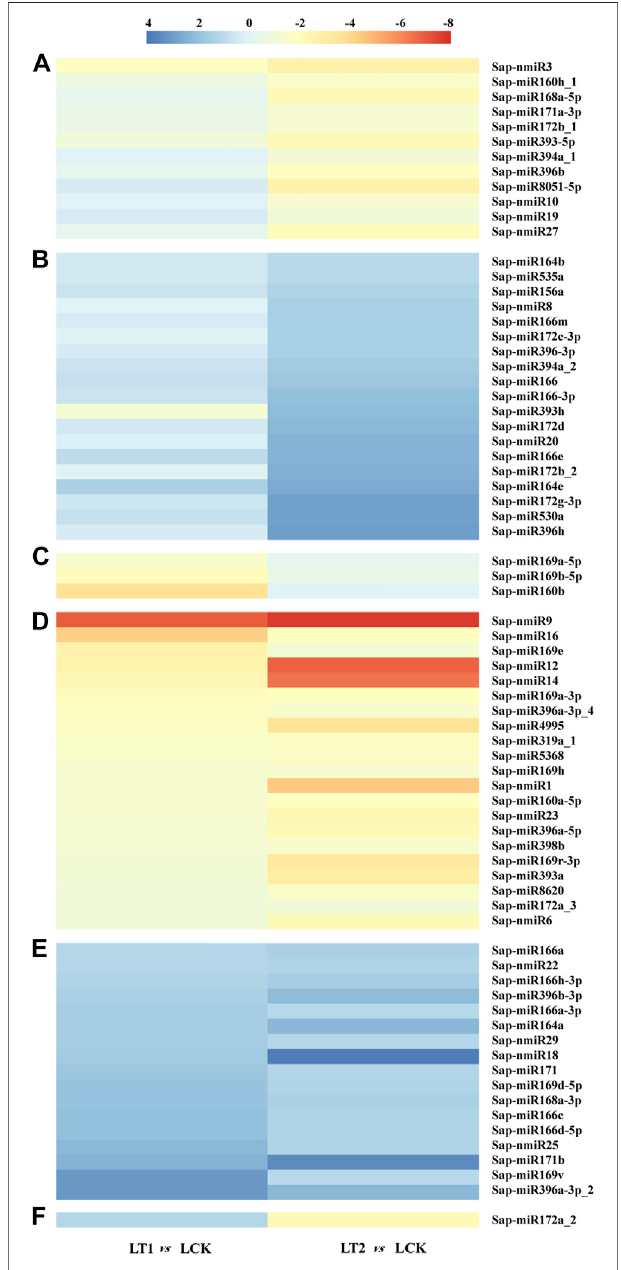
FIGURE 5 | Differentially accumulated S. apetala miRNAs after 0 days (LCK), 1 day (LT1) and 28 days (LT2) of salt treatment. Relative abundance level was calculated with Log 2 (TPM LT1 /TPM LCK ) and Log 2 (TPM LT2 /TPM LCK ). These differentially accumulated miRNAs were divided into six clusters, represented by (A – F)